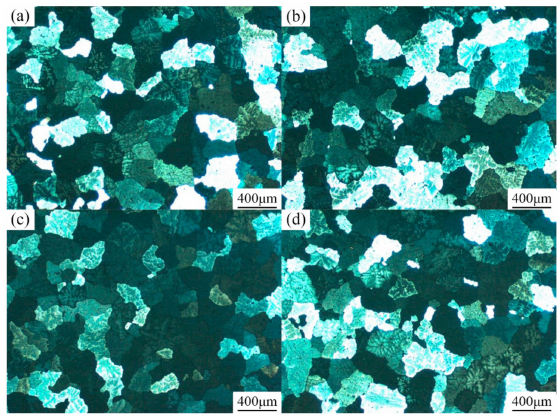
Figure 2. Light optical micrographs of homogenized samples: ( a ) 5083, ( b ) 5083 + 0.03 wt.% V, ( c ) 5083 + 0.05 wt.% V and ( d ) 5083 + 0.10 wt.%